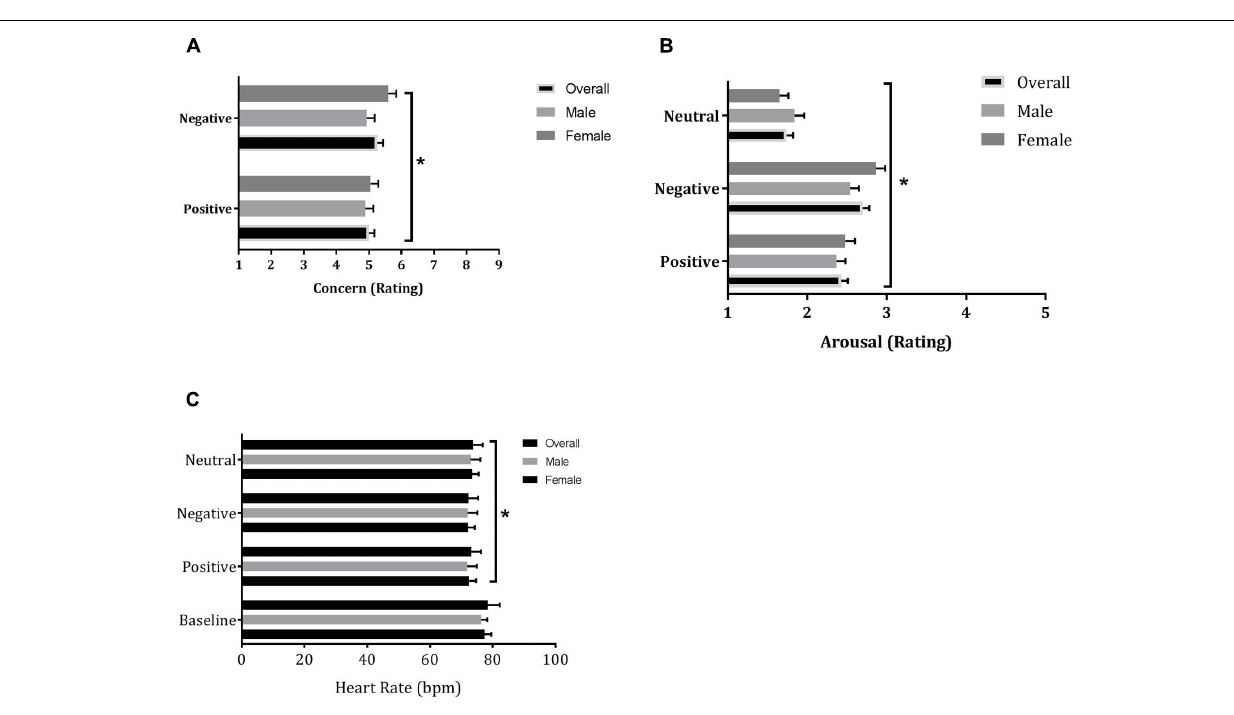
FIGURE 2 | Mean ( ± SE) ratings of Concern (A) and Arousal (B) in response to positive and negative clips and heart rate (bpm) (C) during baseline and positive, negative, and neutral movies in the Multidimensional Movie Empathy Test; ∗ indicates statistical significant main effect at p =